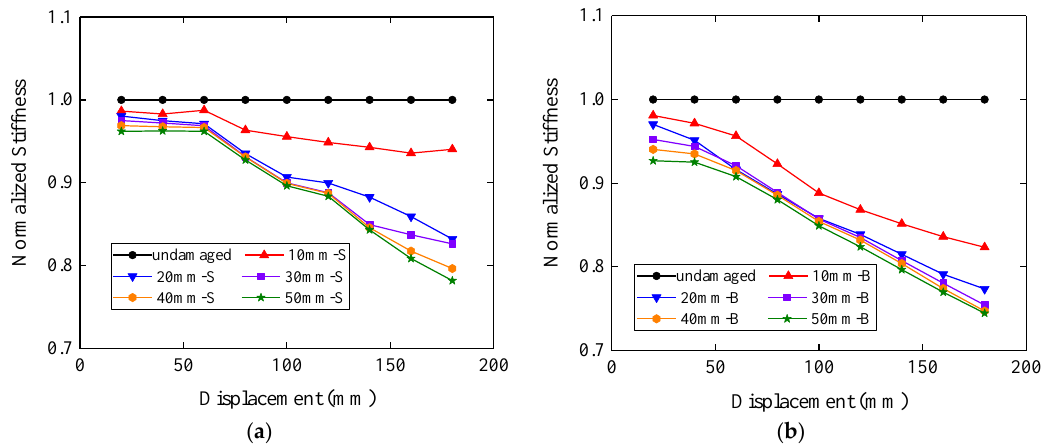
Figure 17. Normalized stiffness: ( a ) Single joint damaged models; ( b ) both joints damaged models.